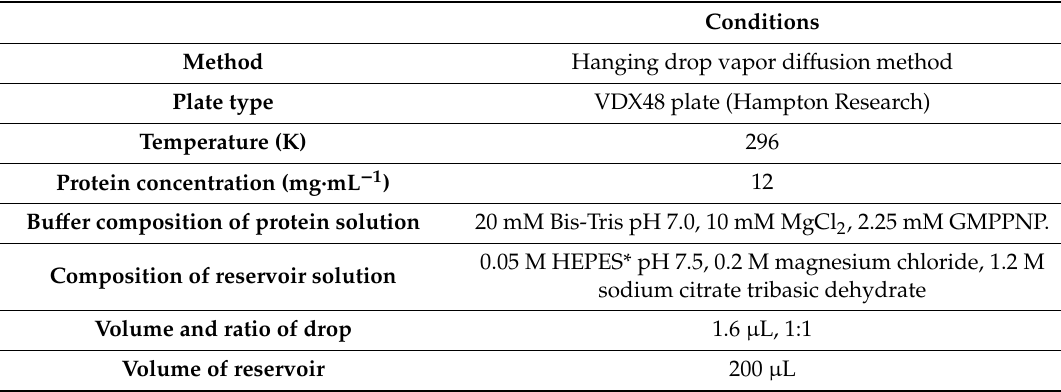
Table 1. Co-crystallization of Yp HddC and Guanosine 5 (cid:48) -( β , γ -imido) triphosphate